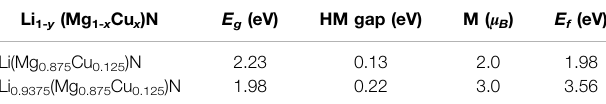
TABLE 1| Theband gaps( E g ),thespin- fl ip/half-metallic gaps(HM gap),magnetic moments (M), and formation energies ( E f ) of Li 1- y (Mg 0.875 Cu 0.125